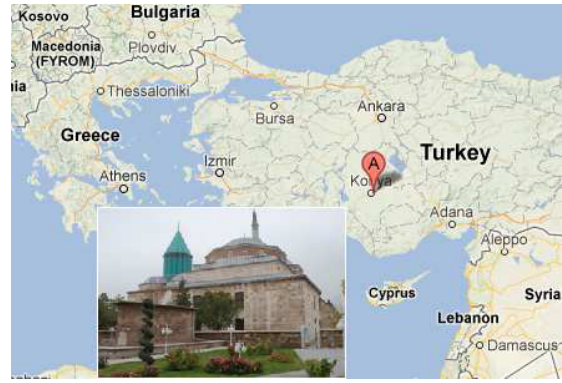
Figure 1. Location of Mevlana Museum (Map is from Google